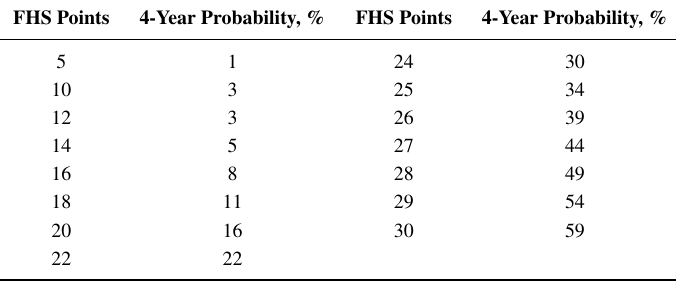
Table 3. Probability of congestive heart failure within four years for men aged 45 to 94